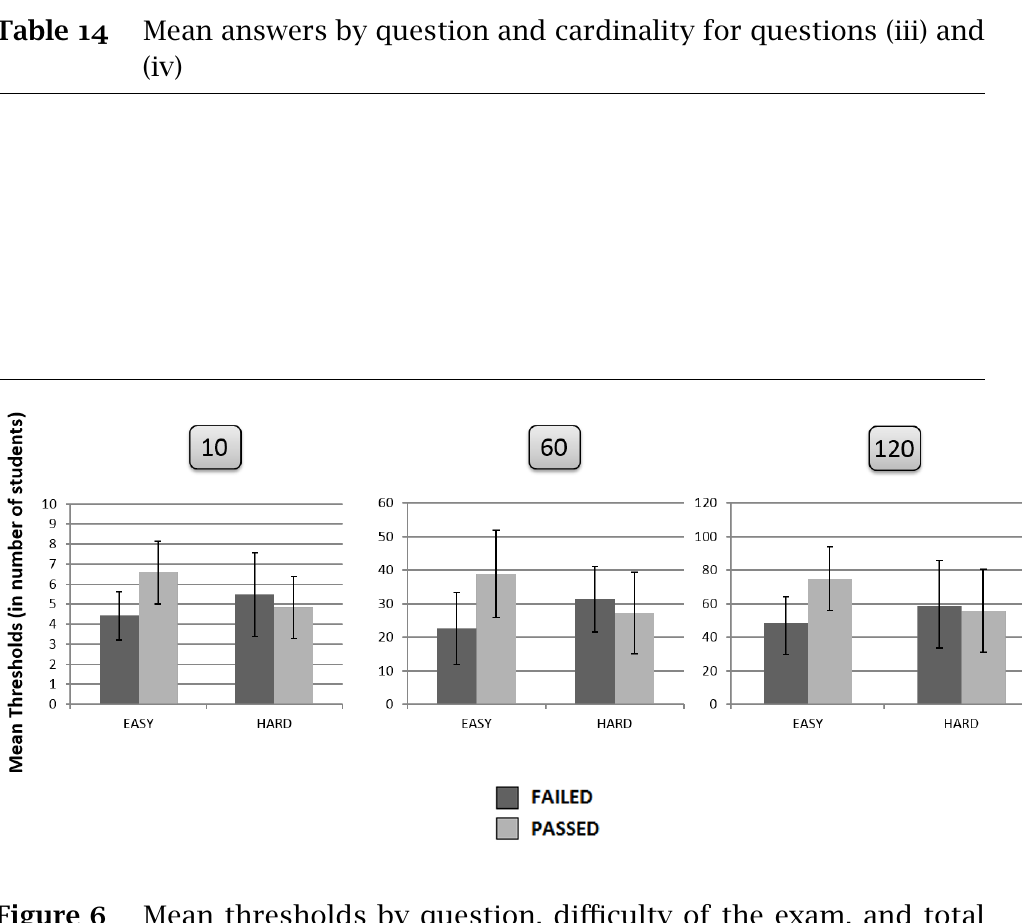
Mean thresholds by question, difficulty of the exam, and total number of students. Error bars indicate standard